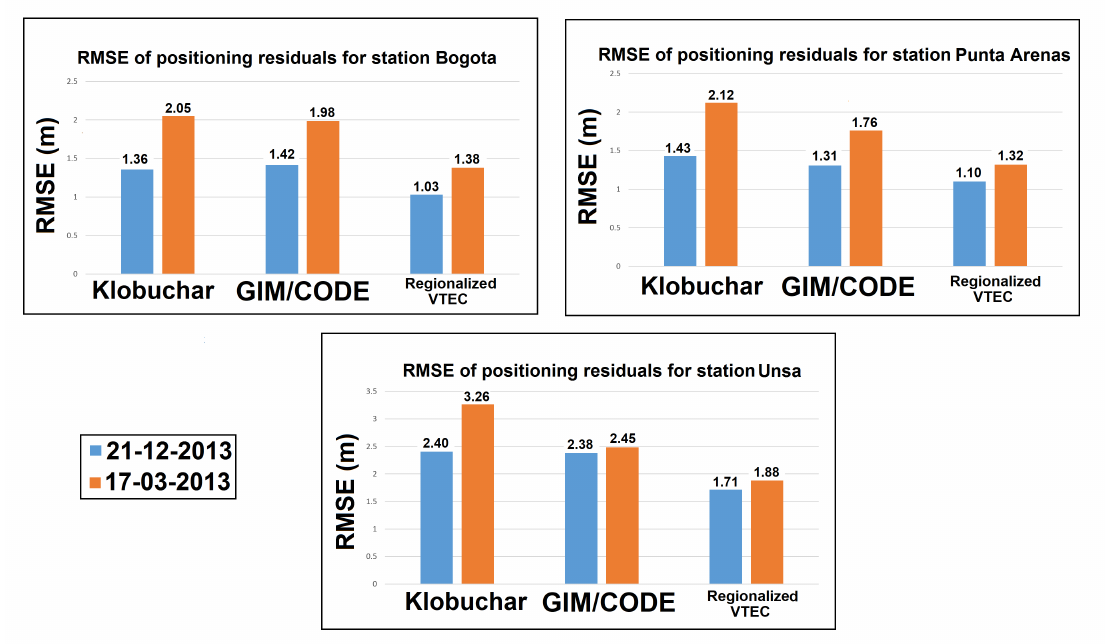
Figure 11. RMSE of positioning residuals for Bogota, Unsa and Punta Arenas during 17 March 2013 and 21 December